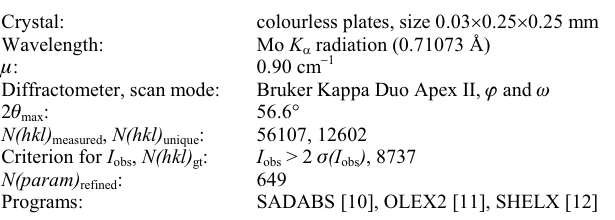
Table 1. Data collection and